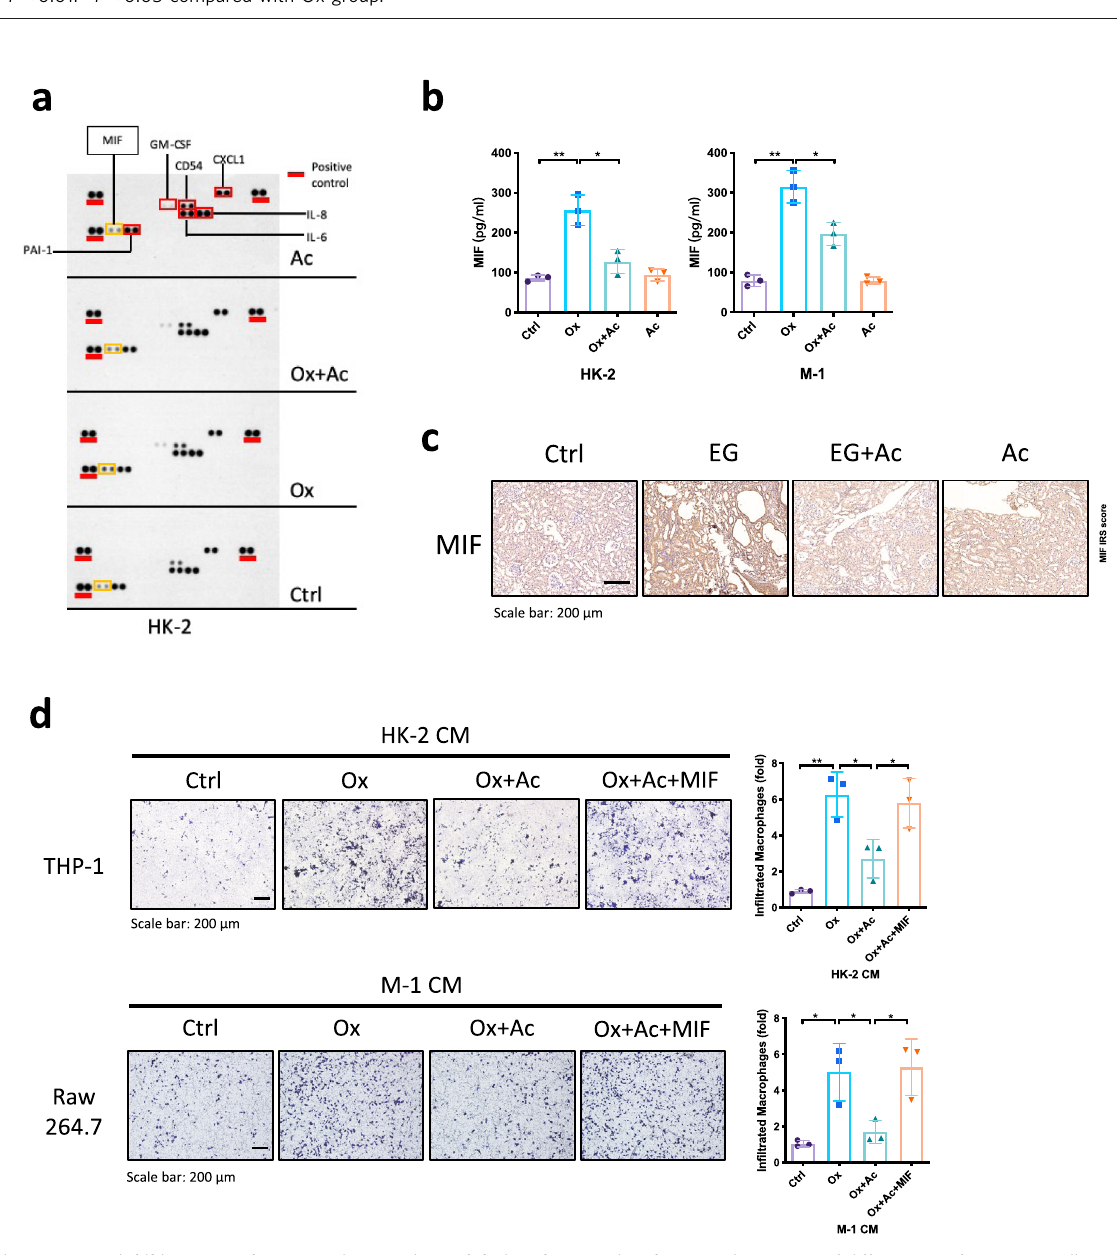
COMMUNICATIONS BIOLOGY| (2023) 6:270 |https://doi.org/10.1038/s42003-023-04649-w|www.nature.com/commsbio